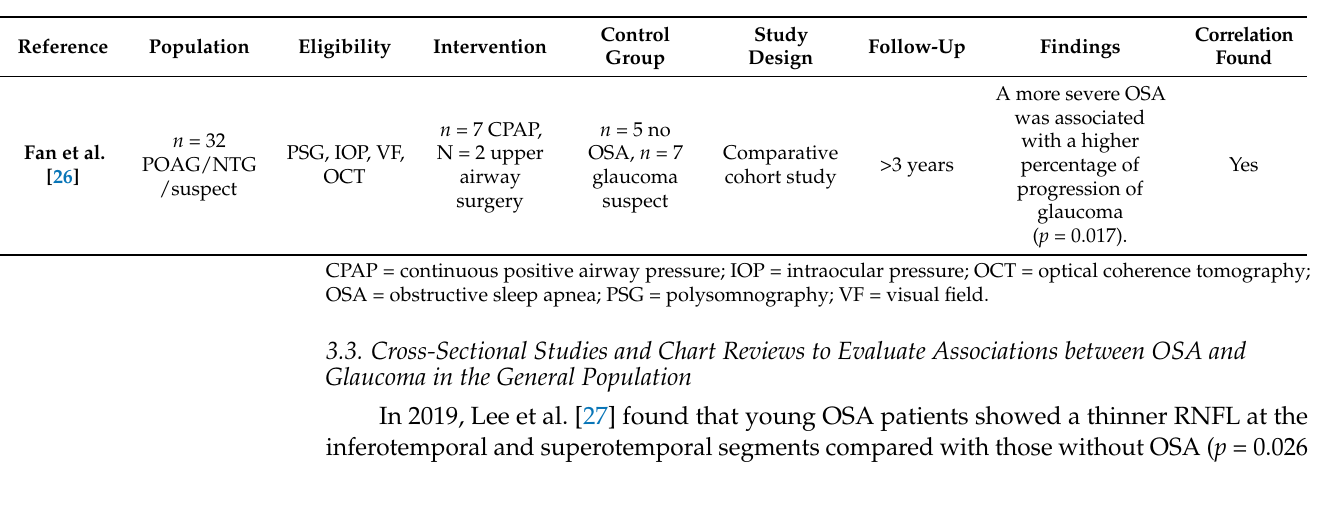
Table 2. Cross-sectional studies on the occurrence of OSA in patients with